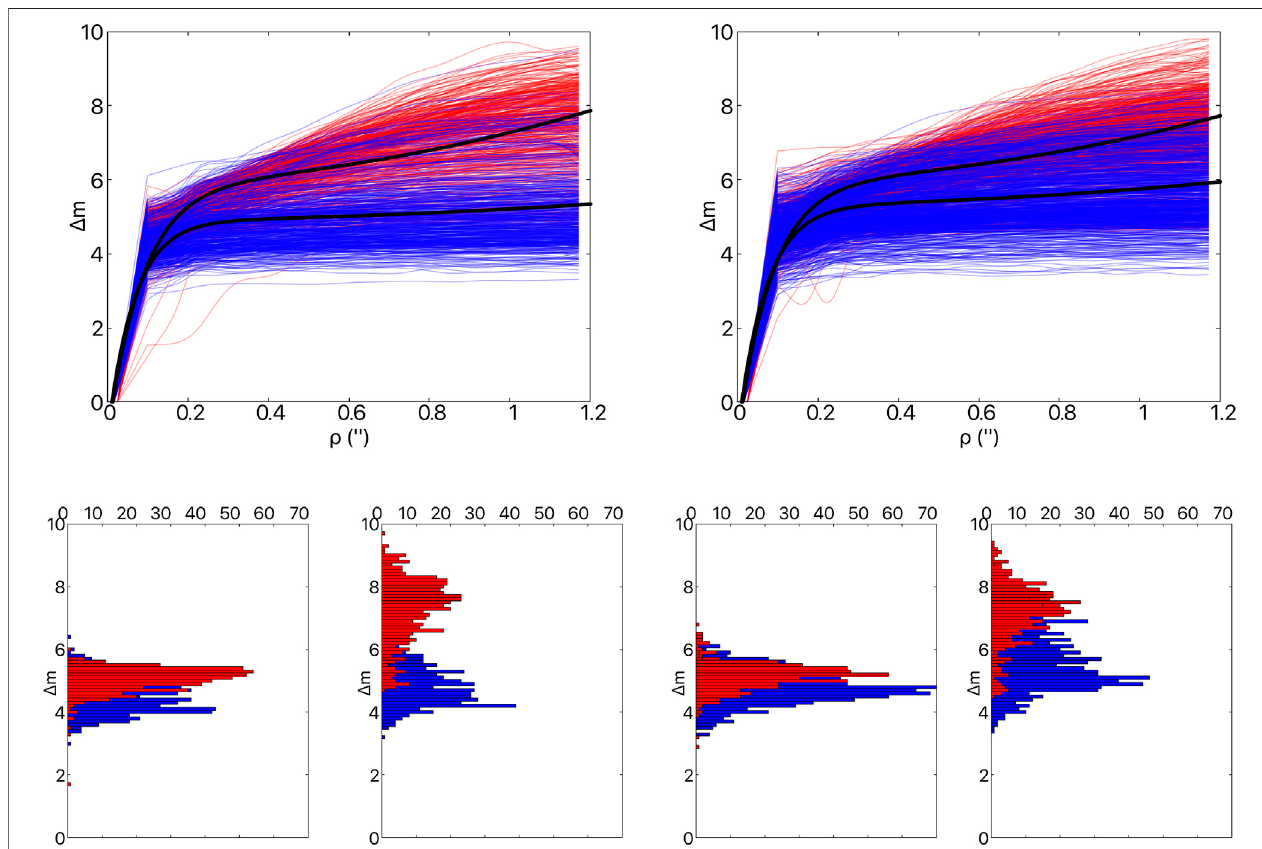
FIGURE 7 | ‘ Alopeke and Zorro Contrast Curves (top left and right, respectively), a compilation of 1,094 5-sigma contrast curves for data taken from 2019 to mid- 2020inthe466,562,716and832 nmchannels.The466and562 nmdataisshown inbluewhilethe716and832 nm dataisshownasred.Theblackcurvesare fi tsto the562and832 nmdata.The bottom rowshowscontrastcurvecutsat0.2and1.0 ″ for ‘ AlopekeandZorro,respectively.Thesecutshelptohighlightthedistributionof the set of contrast curves. The red data typically have better contrast than the blue due to the wavelength dependence of the seeing. Also, targets observed at higher airmass are less likely to be detected in the blue fi lter.